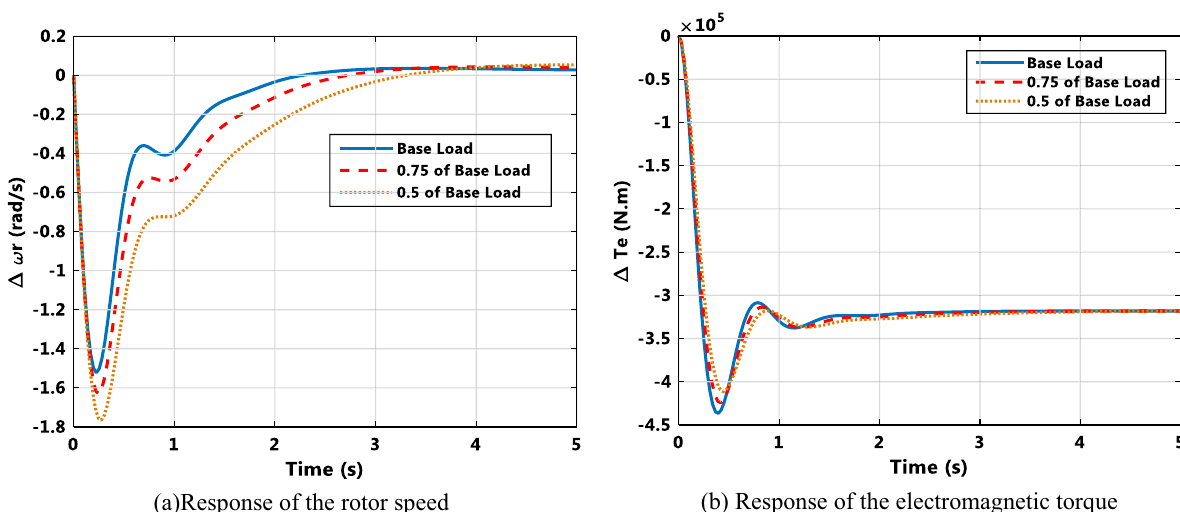
Fig. 11 Step response of speed and electromagnetic torque at different loading